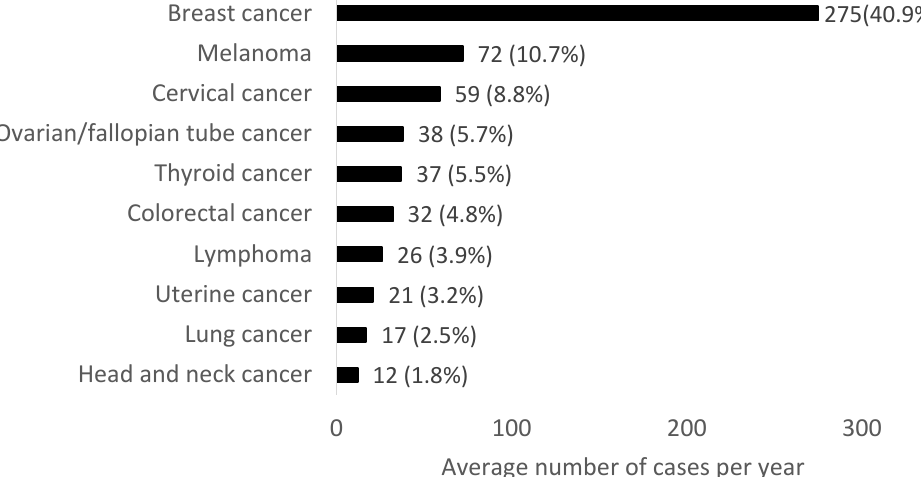
skin cancer) in females aged 18–49 years in Northern Ireland from 2010–2019. Percentages refer to the